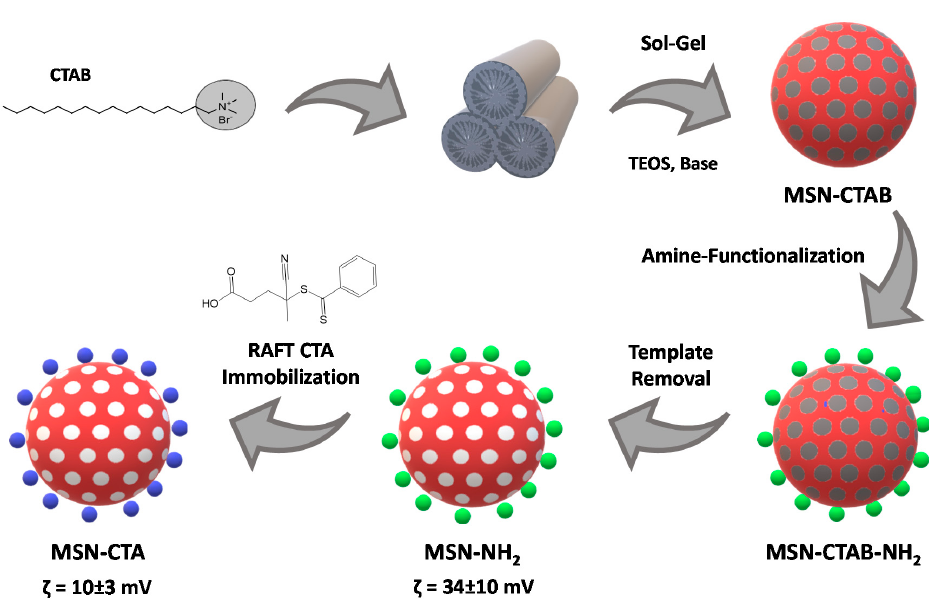
Figure 3. Schematic illustration of the preparation of functionalized MSNs. Zeta-potential values measured at pH = 5.6 reflect the change in surface charge upon surface modification.